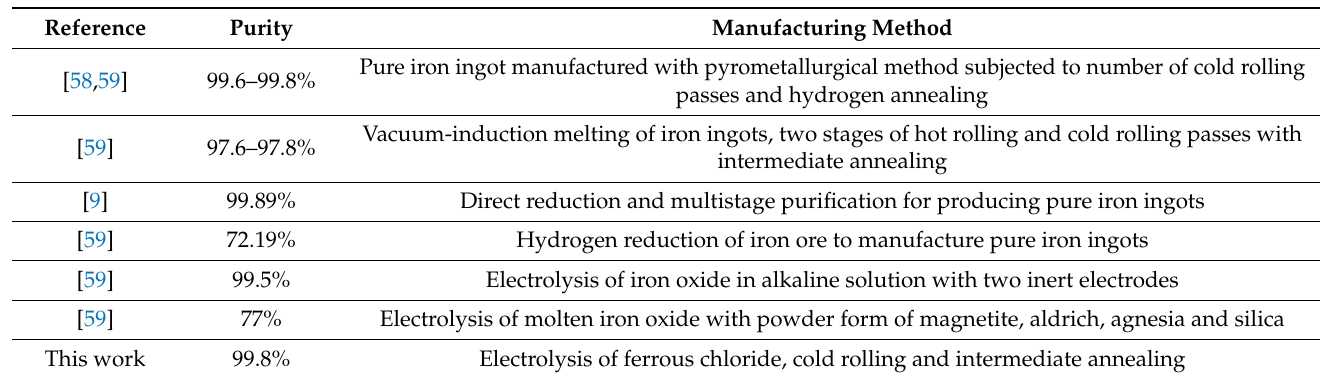
Table 11. Methods for manufacturing of technically pure